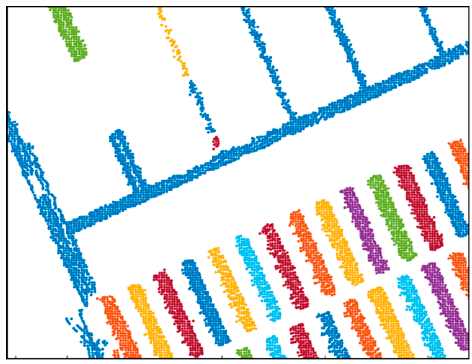
Figure 13. Result of object clustering.